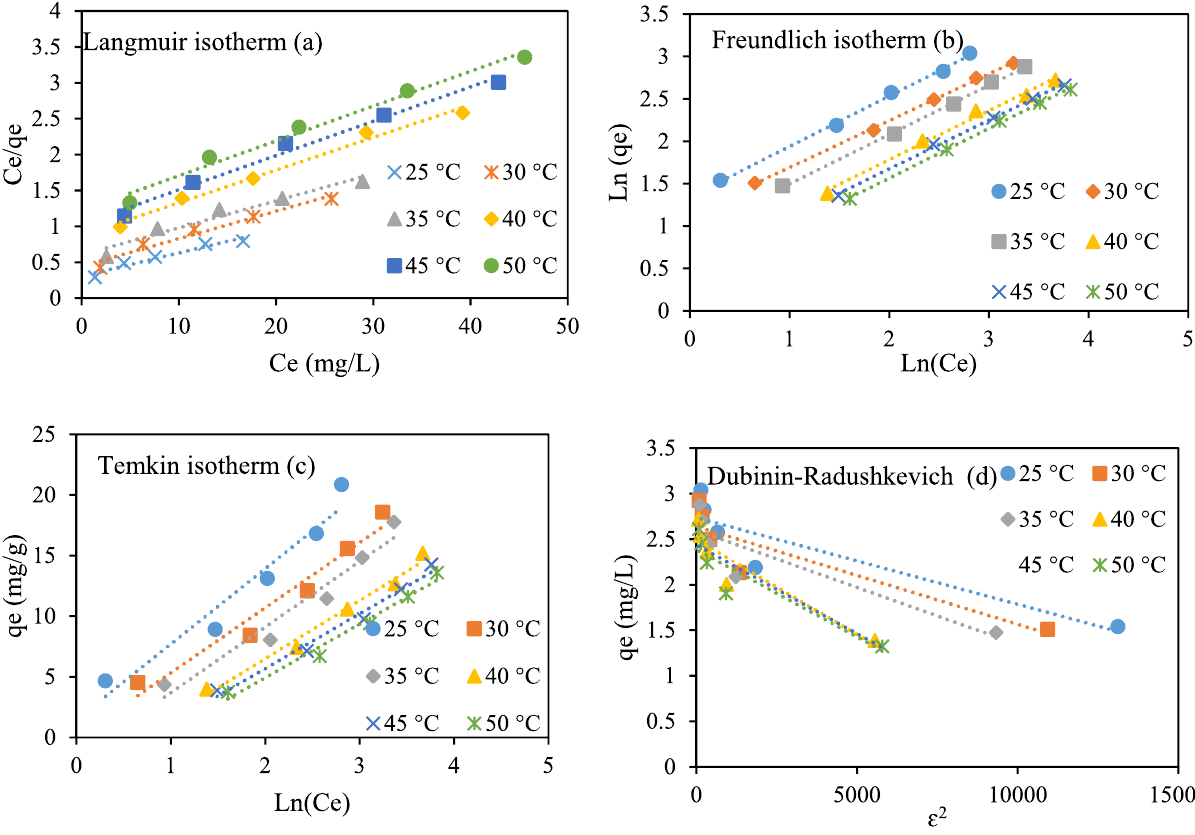
Figure 8. Linear isotherm models for RR 198 adsorption by MSW compost